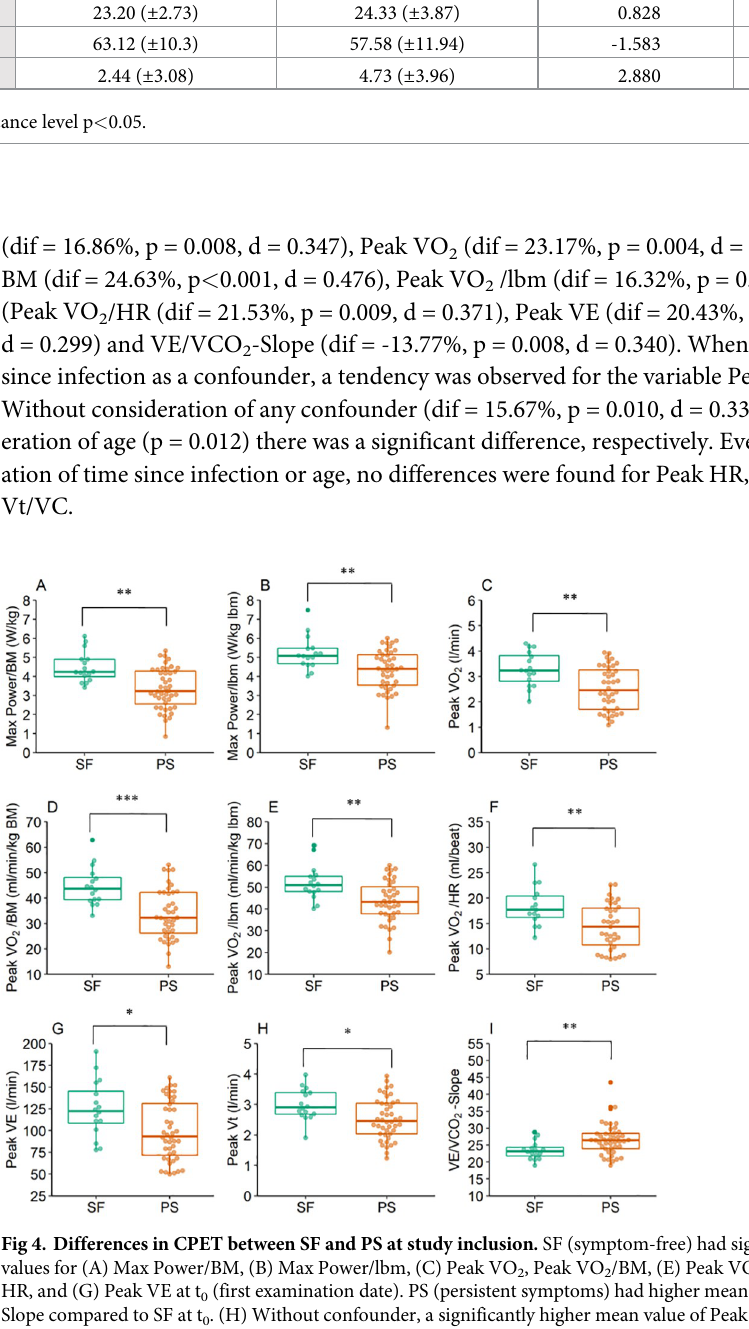
Fig 4. Differences in CPET between SF and PS at study inclusion. SF (symptom-free) had significantly higher mean values for (A) Max Power/BM, (B) Max Power/lbm, (C) Peak VO 2 , Peak VO 2 /BM, (E) Peak VO 2 /lbm, (F) Peak VO 2 / HR, and (G) Peak VE at t 0 (first examination date). PS (persistent symptoms) had higher mean value for (I) VE/VCO 2 - Slope compared to SF at t 0 . (H) Without confounder, a significantly higher mean value of Peak Vt in SF could be observed. � p < 0.05, �� p < 0.01, ��� p <